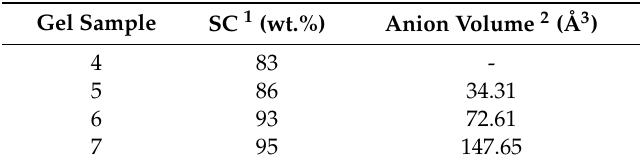
Table 2. Maximum EC / DEC solvent content (SC) and swelling ratio (SR) for the investigated gels as well as the volume of TFSI − , I − and PF 6 − anions.